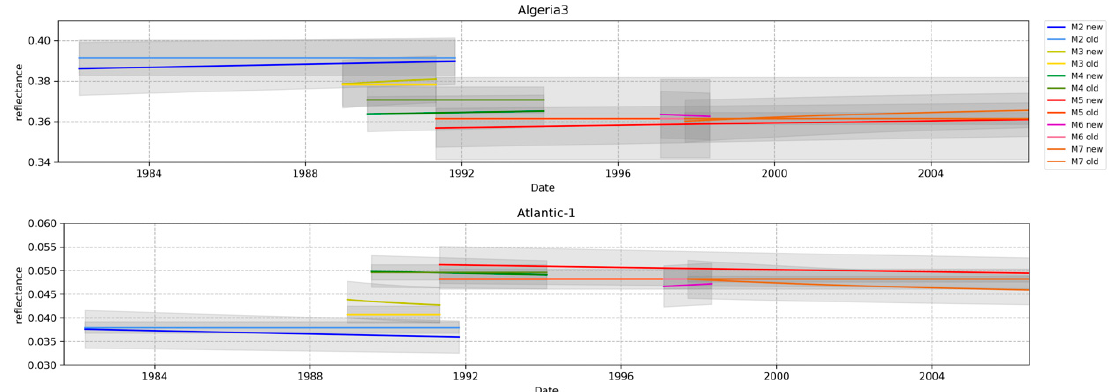
Figure 8. Expected time series at Algeria-3 and Atlantic-1 based on representative mean SCIAMACHY spectra (Figure 2) that are convoluted with the pre-launch SRFs (old) and with the time-variant, reconstructed SRFs (new). Grey shading is the uncertainty of the reflectance computed from the uncertainty provided along with the SRFs.